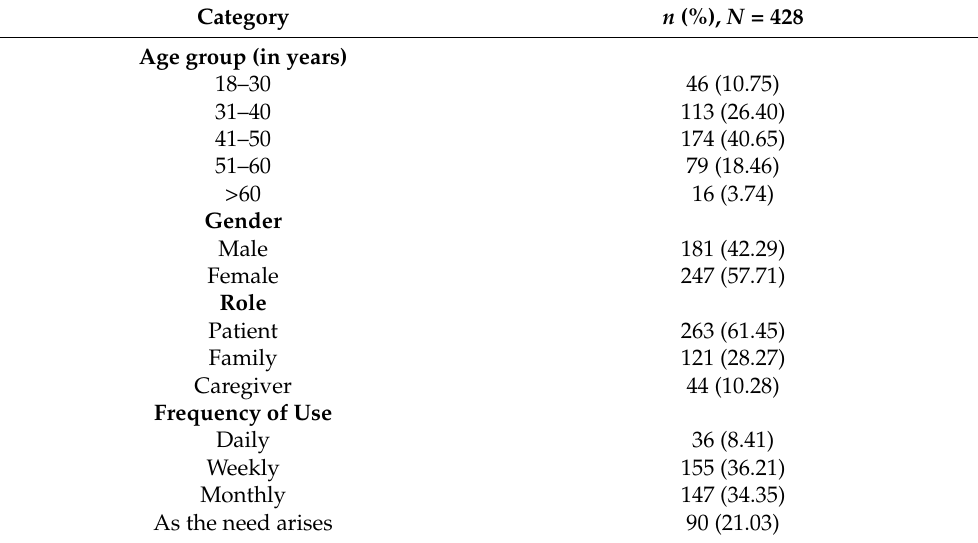
Table 1. Demographics profile of the respondents.